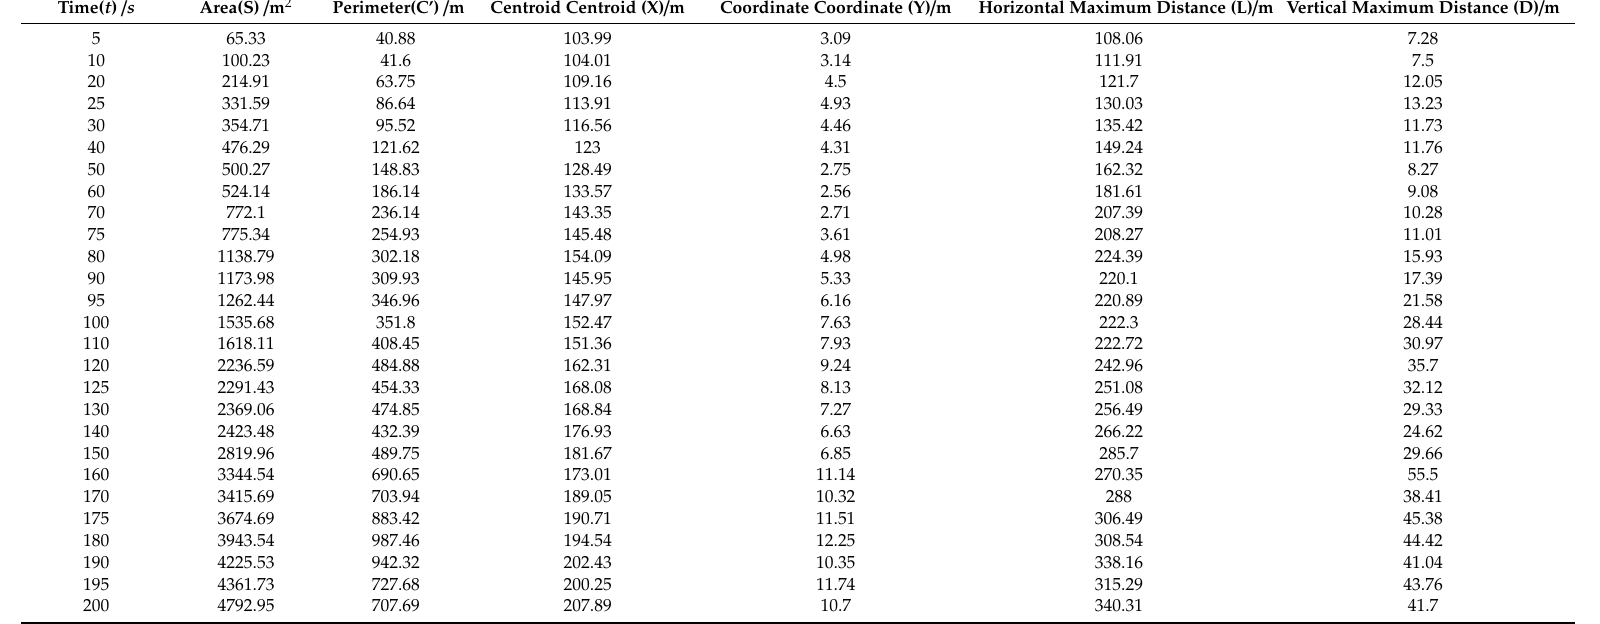
Table 3. Oil-spill parameters extracted from oil-spill trajectory